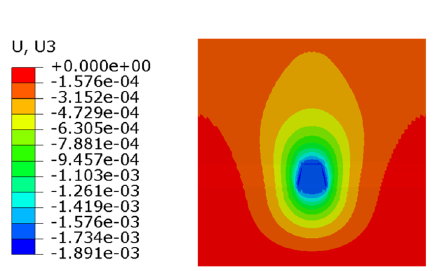
Figure 21. Condition 1 stress cloud diagram.